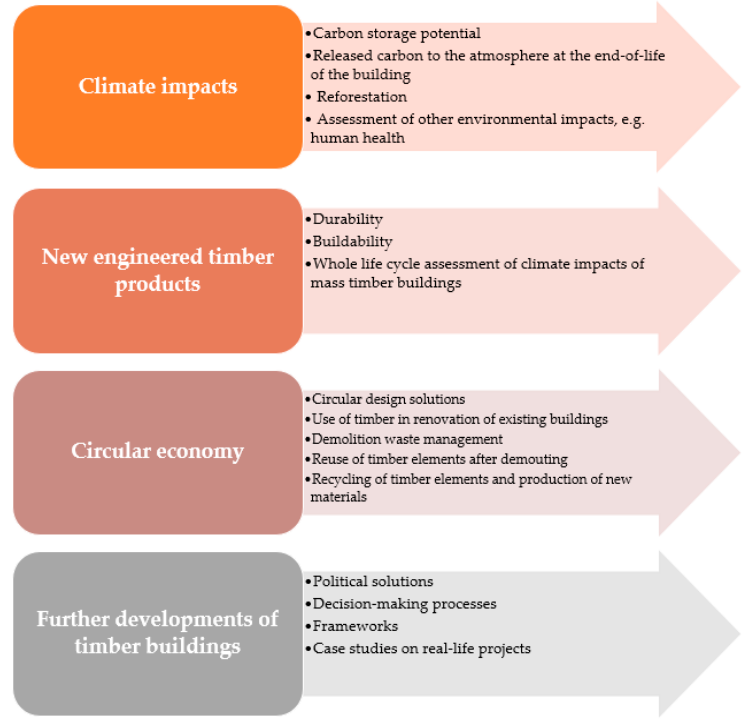
Figure 6. Future research directions.